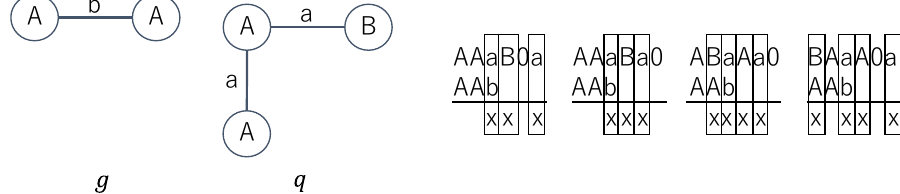
Figure 4. Computation of Graph Edit Distance using AcGM